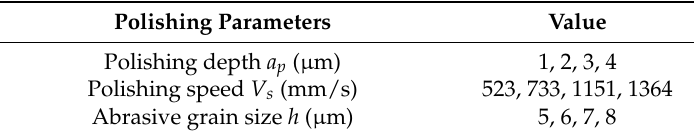
Figure 5. The geometric structure of the three-dimensional (3D) finite element model. Table 4. Parameters for numerical